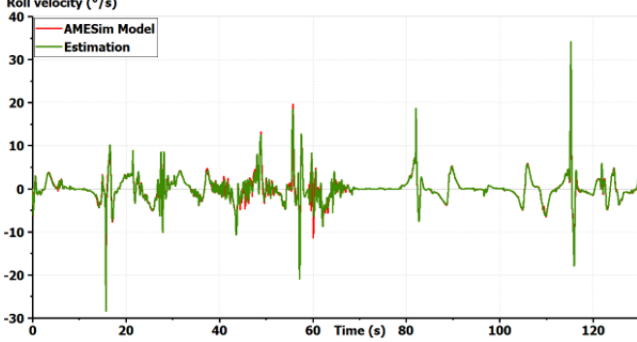
Figure 9. Validation of the vehicle model: roll velocity [10].